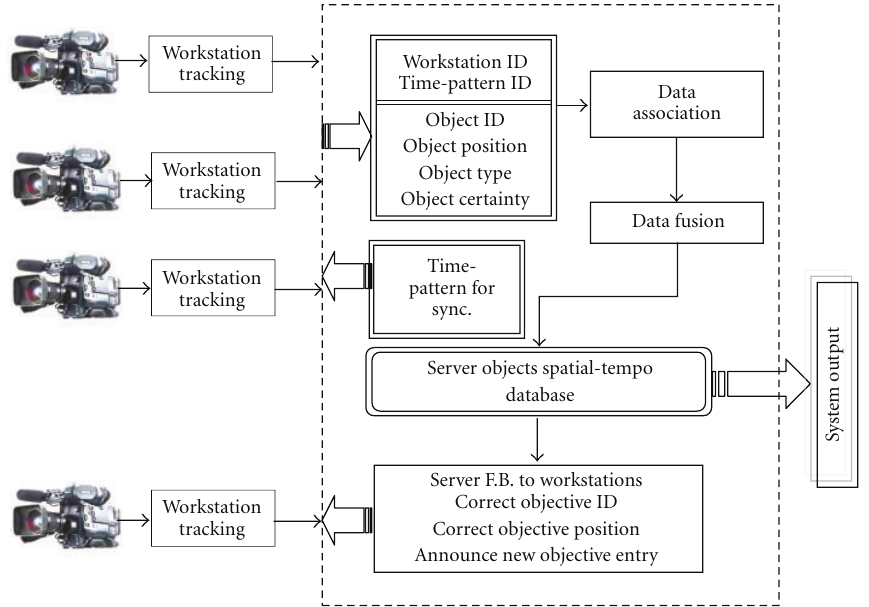
Figure 9: Server jobs and interactivity with